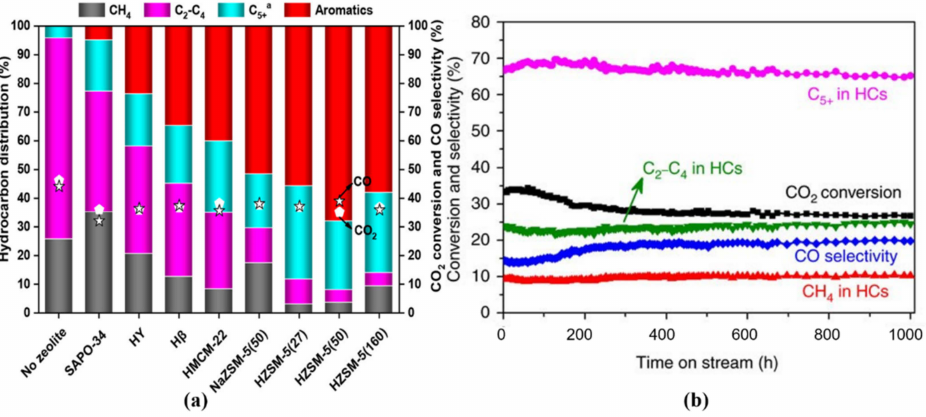
Figure 12. ( a ) Effects of zeolite type on CO 2 conversion and product selectivity over the FeK1.5@HSG/zeolite catalysts. Reaction conditions: 340 ◦ C, 2.0 MPa, GHSV = 26,000 mL · g cat − 1 · h − 1 , H 2 /CO 2 = 3. Reprinted with permission from Wang et al. [112]. Copyright (2019) American Chemical Society. ( b ) The stability of the Na-Fe 3 O 4 /HZSM-5 catalysts with dual-bed configuration.